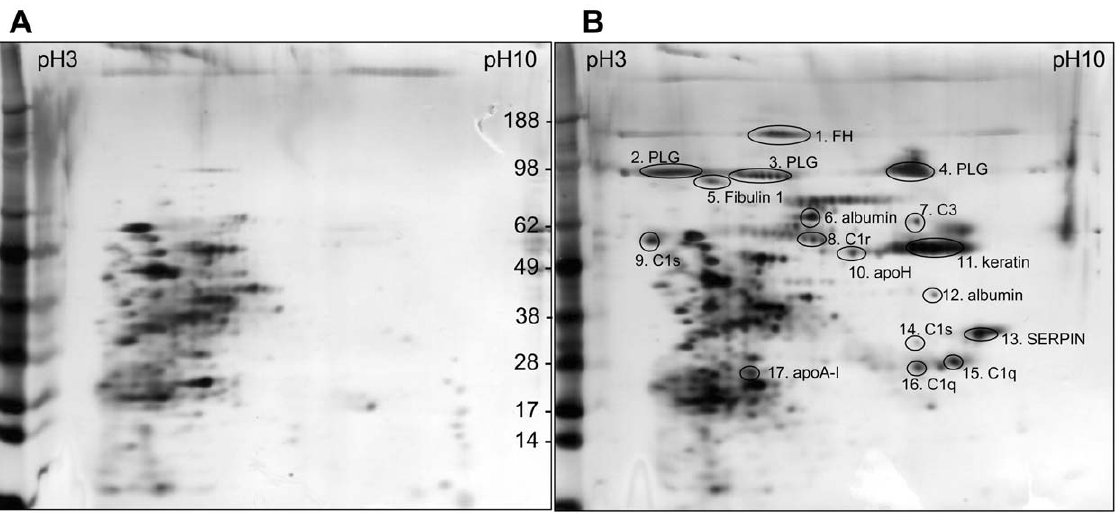
Figure 1. 2D gel analysis of human serum proteins interacting with B.anthracis Sterne spores. Proteins were eluted from NHS-treated spores and separated by 2D electrophoresis. Proteins were visualized by silver staining and were identified by LTQ-MS/MS as described in Materials and Methods. (A) Control eluates from spores alone without NHS. (B) Proteins eluted from NHS-treated spores by a chaotropic reagent. Protein identifications by LTQ-tandem MS/MS were indicated in gel B.